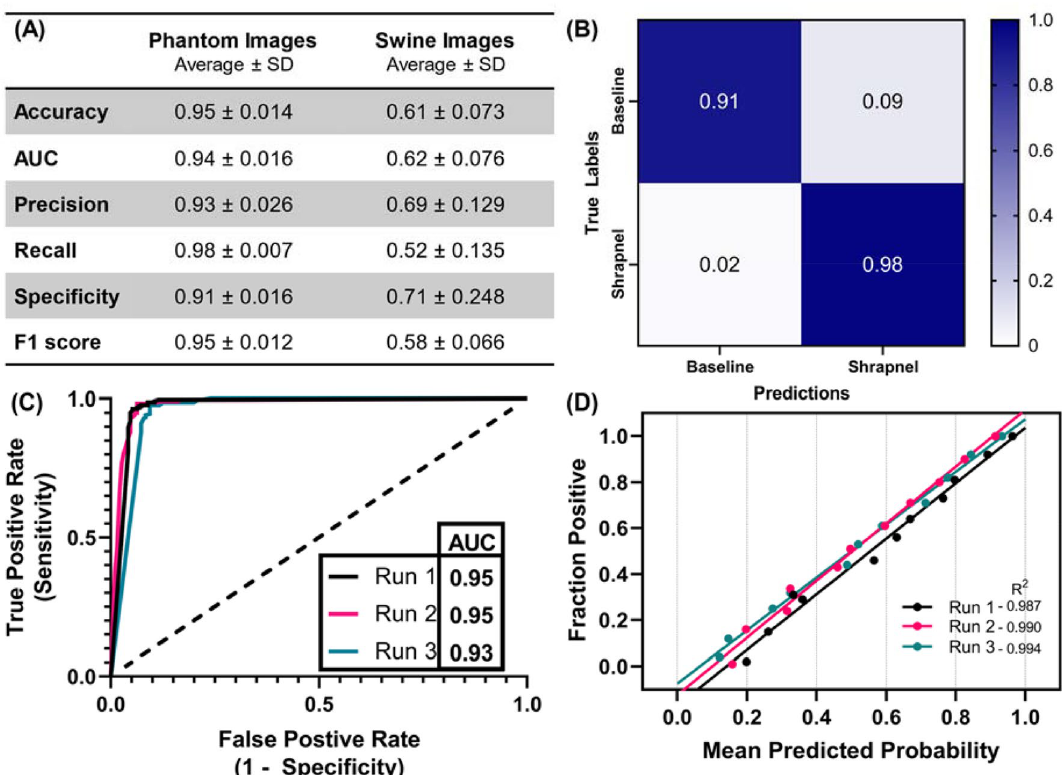
Figure 4. Performance of the Optimized Model using Phantom Image Training. Three replicate models were created with different randomized training-validation splits. ( A ) Tabular statistics for phantom images and swine images. Average and standard deviation (SD) are shown for each statistic. Note that the shown swine predictions are from a model trained only on a phantom image set. ( B ) Average confusion matrix performance. ( C ) ROC curve and ( D ) calibration plots for test data